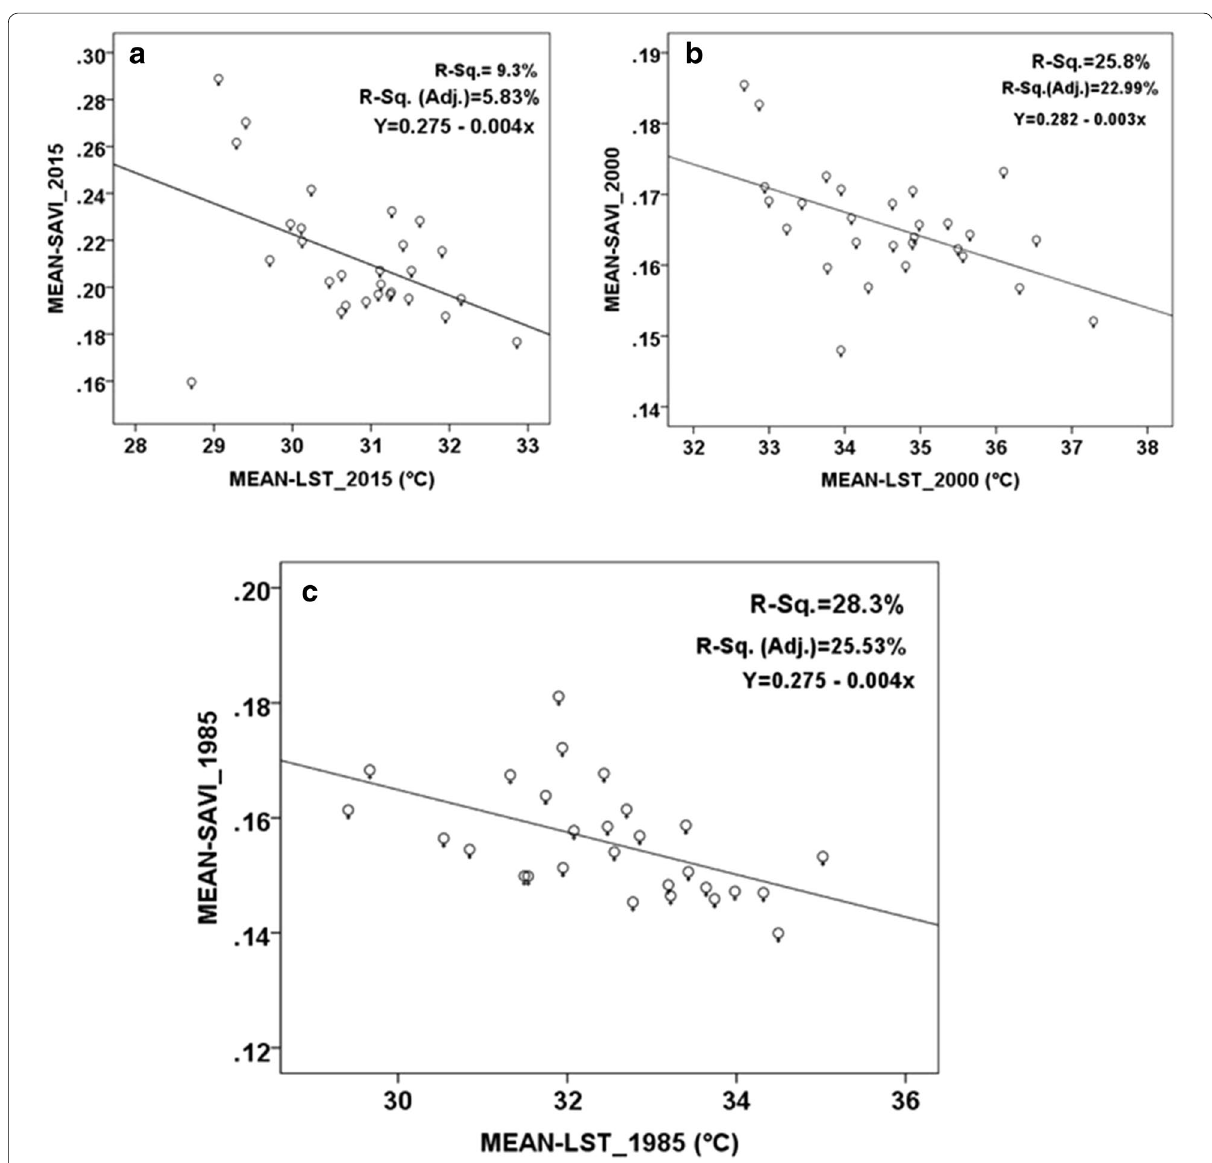
Fig. 10 Linear regression of mean SAVI and mean LST by village’s polygon over years 1985, 2000, and 2015. a regression plot of mean SAVI 2015 and mean LST 2015; b regression plot between mean SAVI of 2000 and LST of 2000; and c regression plot of mean SAVI 1985 and mean LST 1985 (all at village